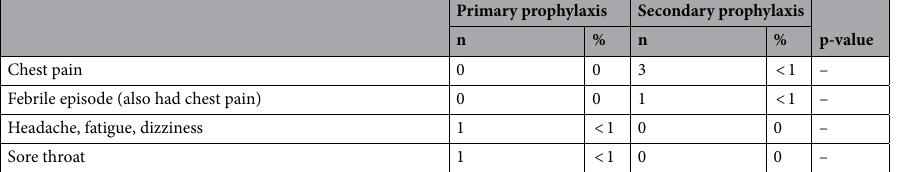
Table 2. Endoscopy level characteristics of primary and secondary prophylactic endoscopy, p-value < 0.05